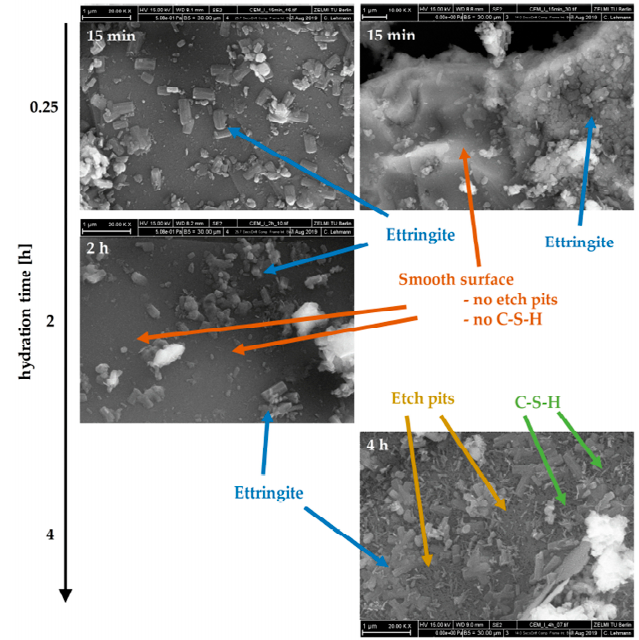
Figure 4. SEM-images of the cement paste at di ff erent hydration times (15 min, 2 h and 4 h). For hydration the CEM I was used with a w / c-ratio of 0.36. The precipitation of di ff erent hydrate phases can be observed. From the first 15 min of hydration on ettringite precipitates, and at later times C–S–H are